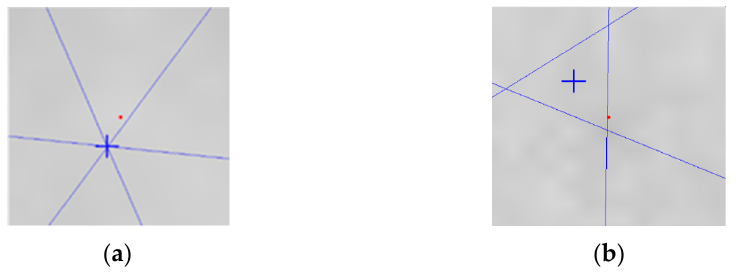
Figure 6. Using the intersection of diagonally adjacent lines to determine parallelism: ( a ) Intersected; ( b ) Not intersected.